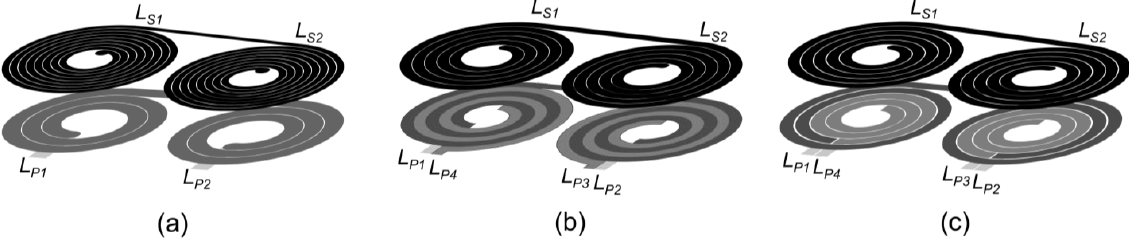
Figure 4. Three-dimensional (3D) views of isolation transformer configurations for DC-DC conversion. ( a ) Stacked topology; ( b ) three-winding interleaved transformer; ( c ) three-winding tapped transformer. Reproduced from [19]. Copyright 2018, Elsevier.